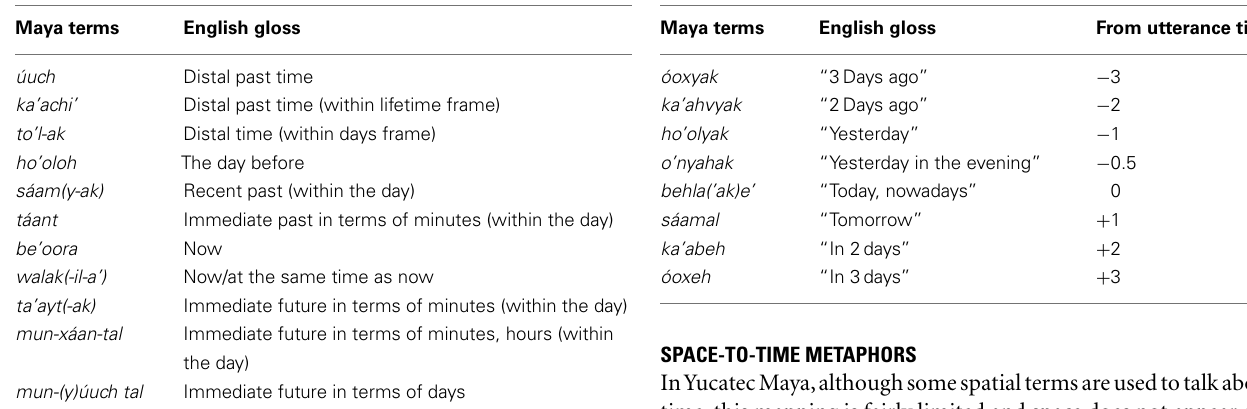
Table 1 |Temporal adverbs inYucatec Maya. Table 2 | Indexical adverb for